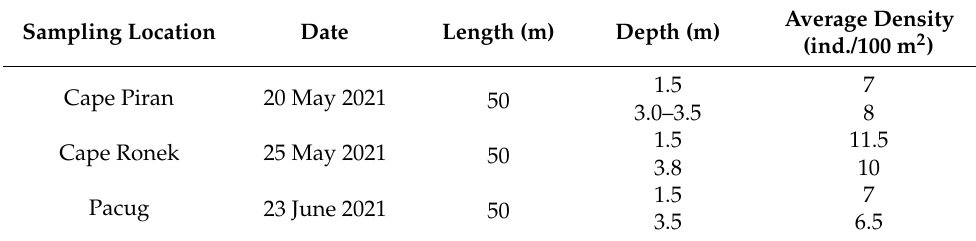
Table 3. Painted comber densities at sampling locations in Slovenian waters.